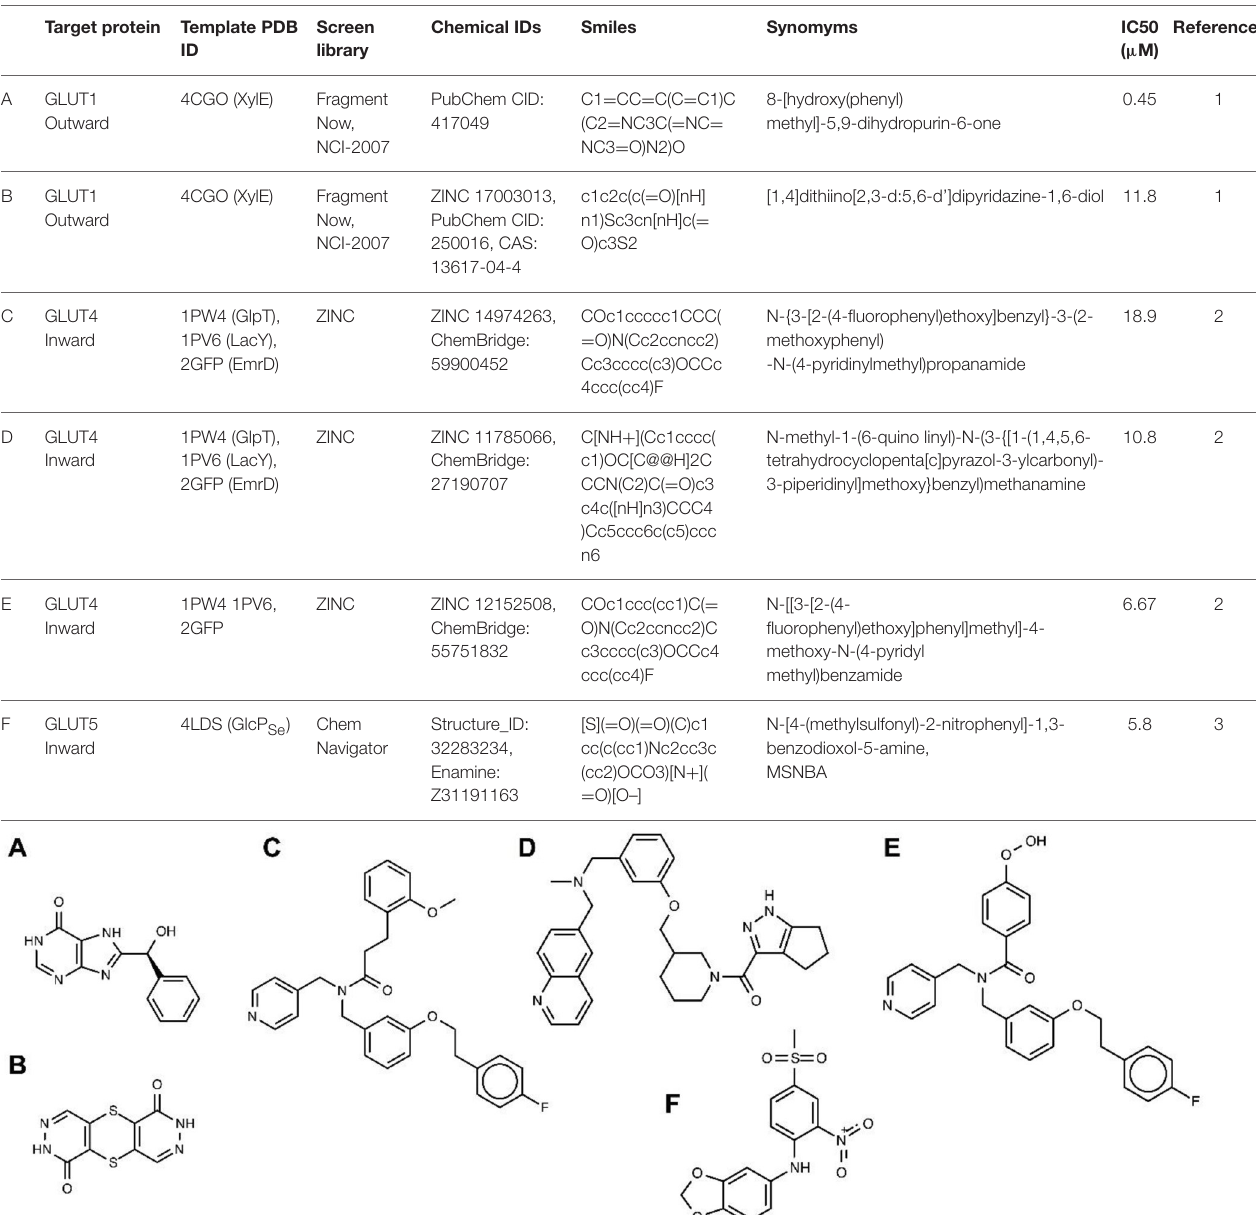
TABLE 2 | Leading probes for GLUTs from in silico ligand